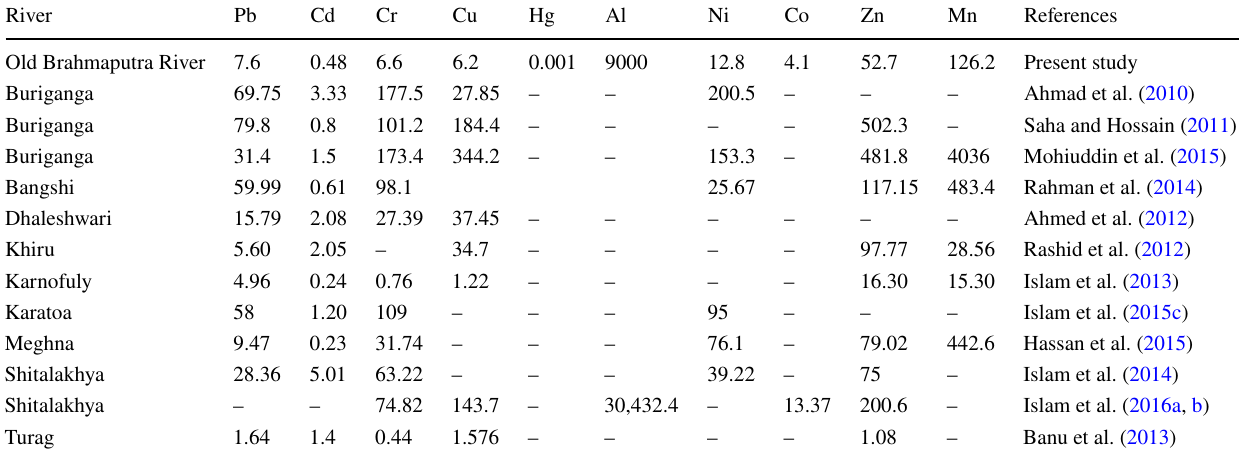
Table 5 Comparison of the observed values of heavy metals in the surface sediment of the Old Brahmaputra River with other rivers of Bangla- desh